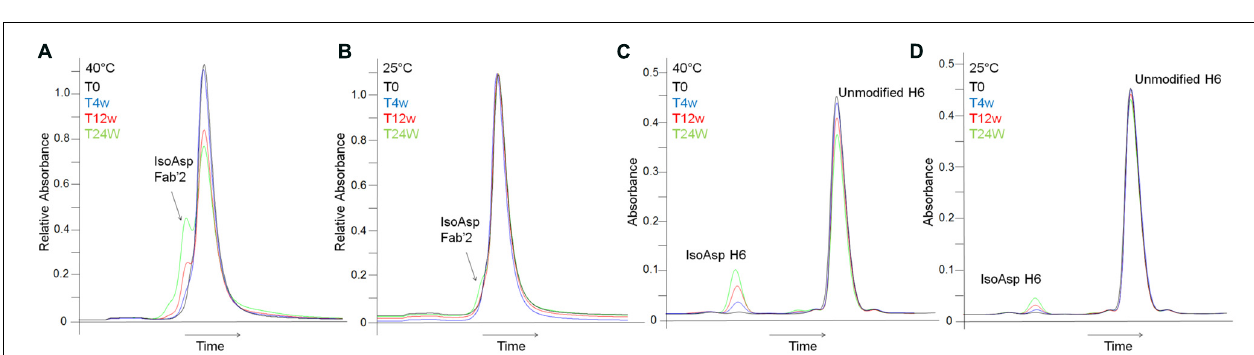
FIGURE 3 | Isolation and potency evaluation of isoAsp containing antibody. (A) HIC separation of isoAsp from main peak in stressed (dashed) material. Unstressed material is shown for reference (solid). Stressed material was collected in two fractions indicated by the vertical black lines. The x-axis has been normalized to the main peak to account for normal